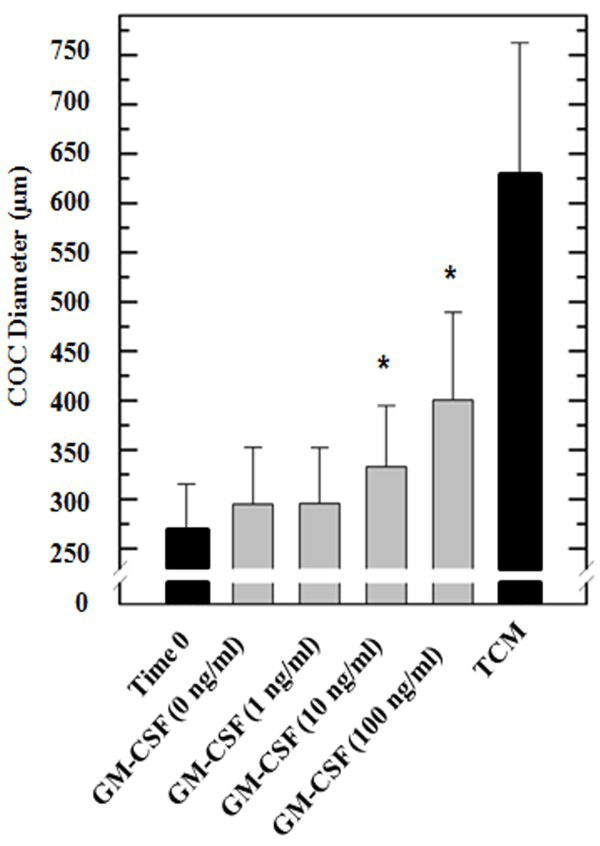
Effect of GM-CSF on diameters of cumulus in in vitro matured COC. (A) COC (n = 52-56/per group) were in vitro matured in SOF medium alone or supplemented with 1, 10 and 100 nM of GM-CSF. (B) Higher (P < 0.001) diameters were detected in COC matured in presence of 10 and 100 ng/ml of GM-CSF compared to untreated COC. Time 0 corresponds with the immature state of the oocytes. Parameters from oocytes in the immature state and matured in TCM were used as positive control and not included in the statistical analysis. (*) Indicate significant (P < 0.001) differences between treatments of 0, 1 and 100 ng/ml of GM-CSF.